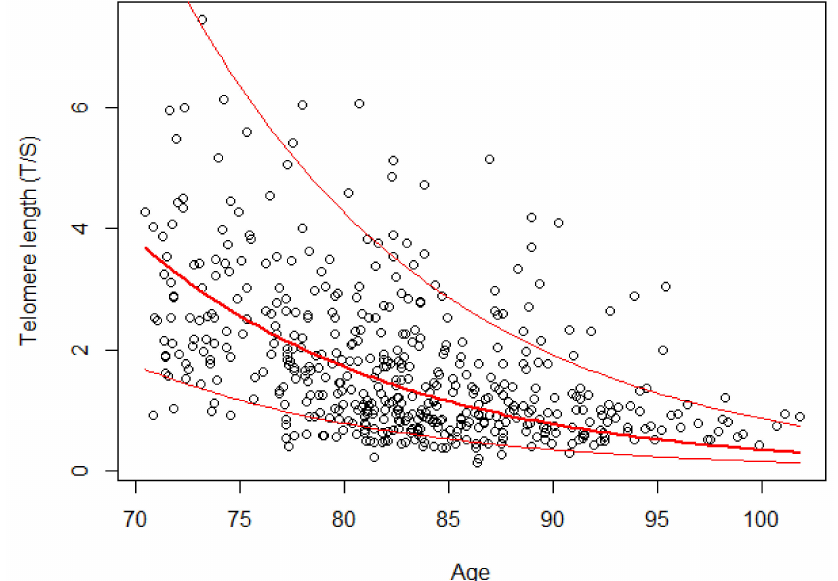
Figure 2. Telomere length versus age in the group of 162 subjects. The red lines indicate the random- effects model estimated on a logarithmic scale and the range of variation due to the addition of the individual random